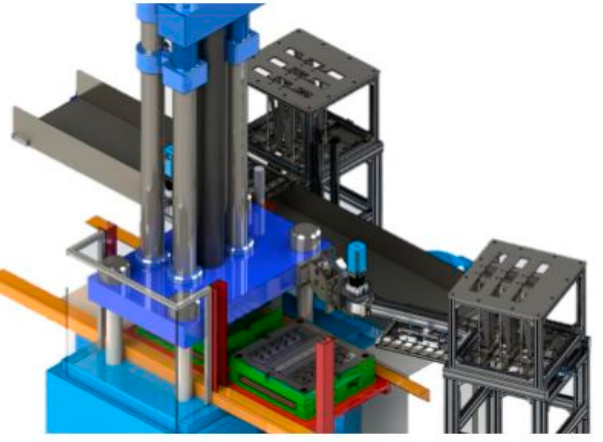
Figure 12. 3D view of the injection machine, provided with two feeding towers, two grippers, and one common conveyor belt.